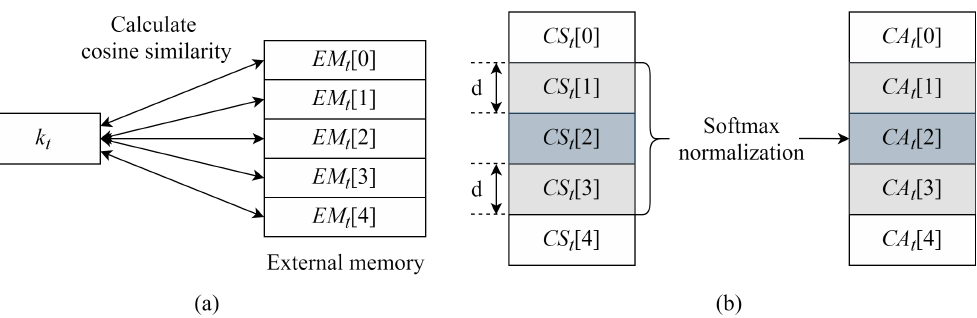
Figure 2. Overview of localized content-based addressing at time t . ( a ) The cosine similarity is calculated using a key vector k t and each external memory address. EM t [ i ] is the i -th vector of